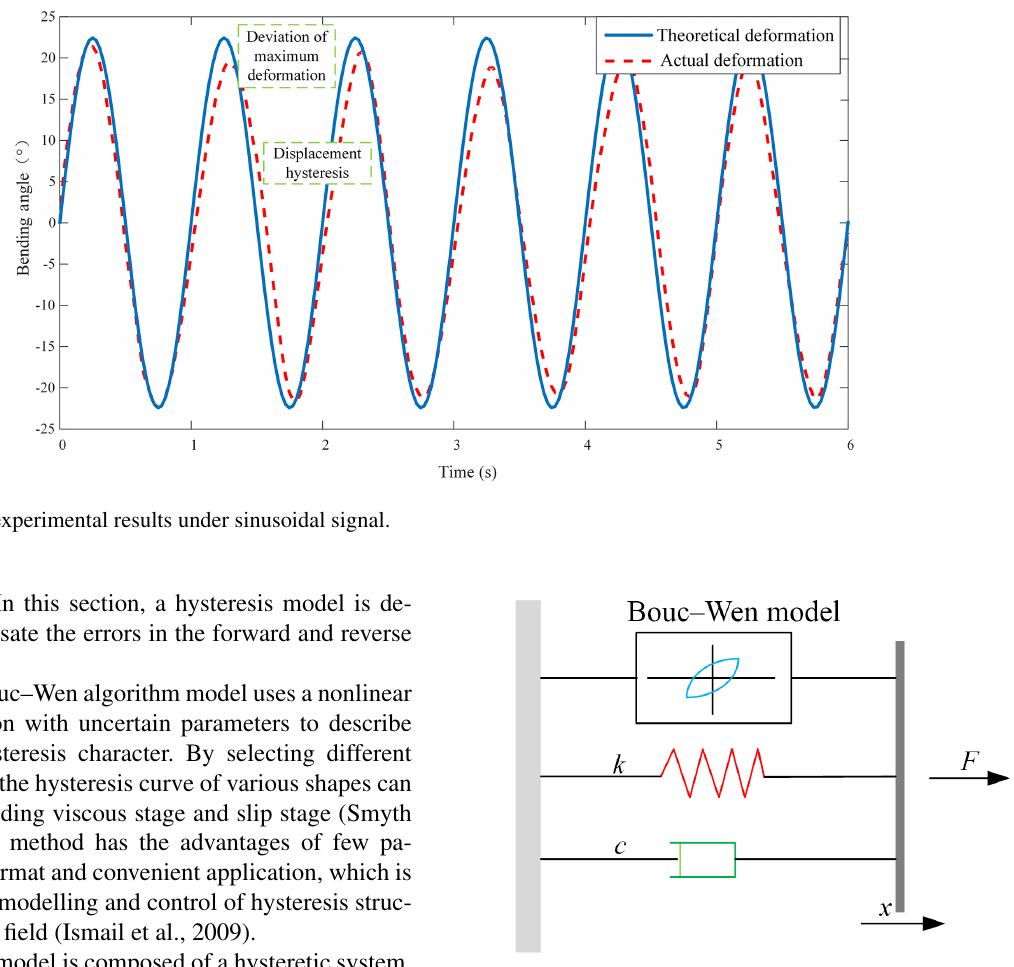
Figure 7. Diagram of the Bouc–Wen